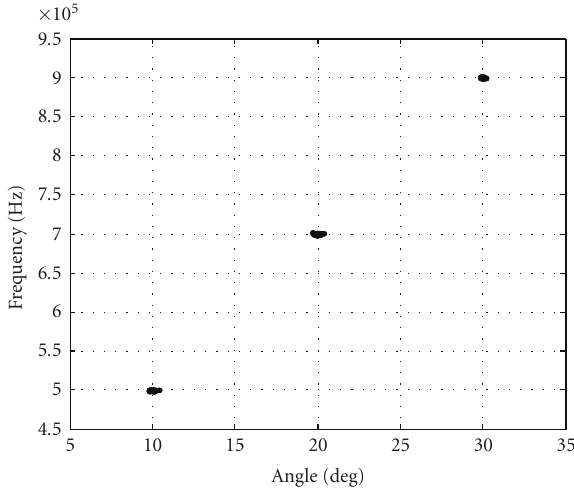
Figure 3: Angle-frequency scatter, SNR =